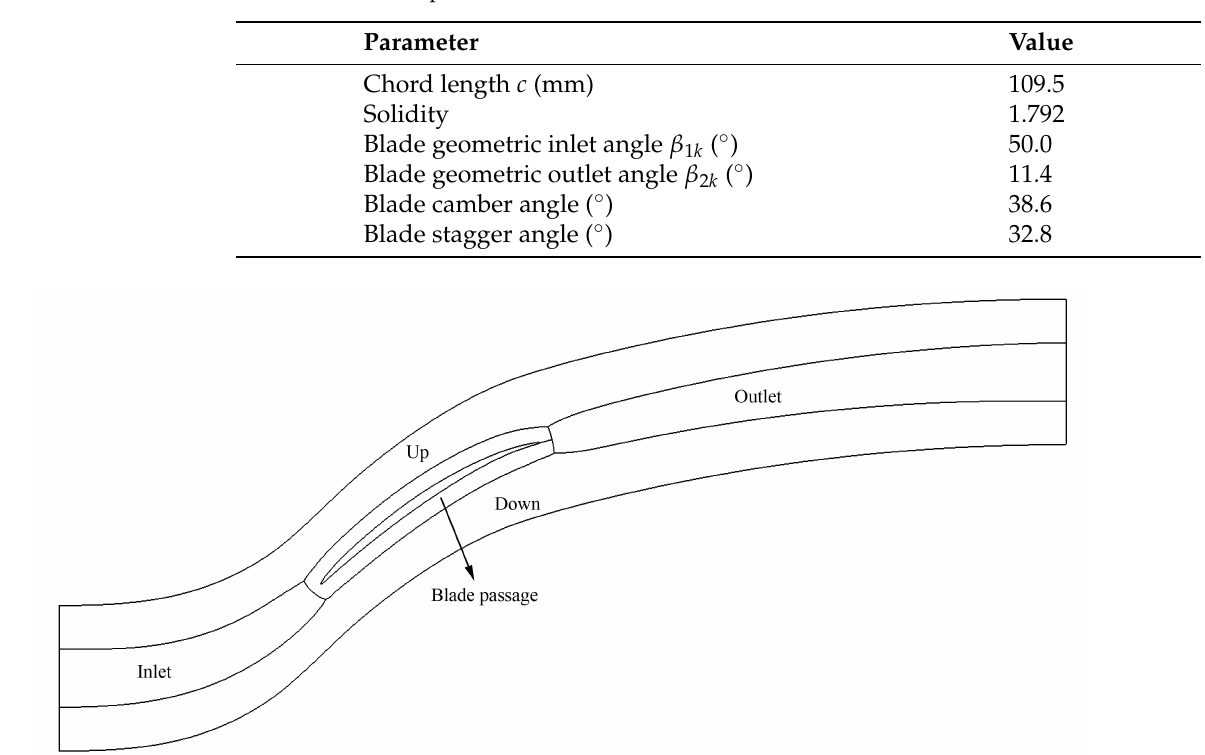
Table 2. Geometric parameters of cascade.